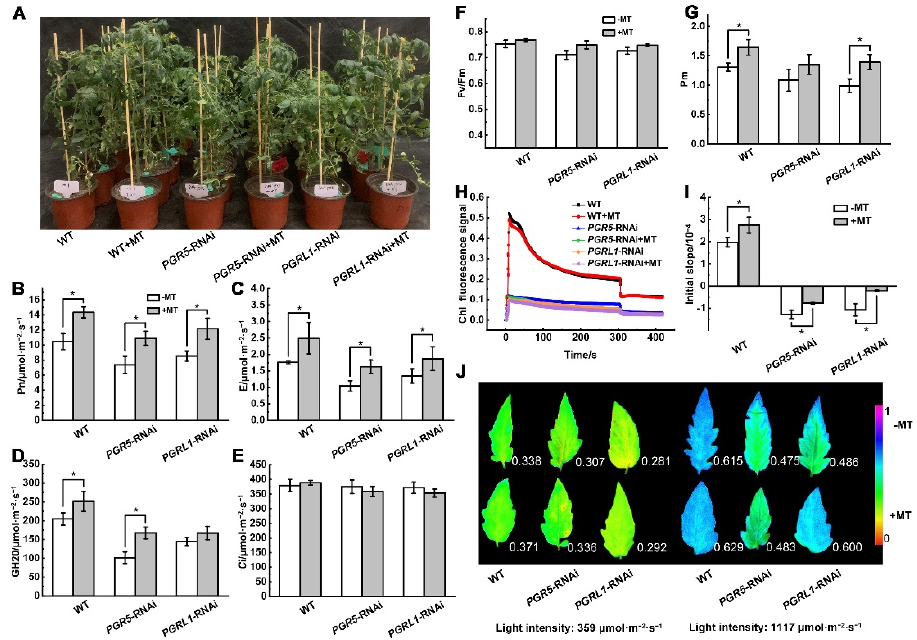
Figure 4. The effect of exogenous melatonin on photosynthetic gas exchange and chlorophyll fluorescence of tomato plants subjected to low night temperature. Plant phenotype ( A ); net pho- tosynthetic rate ( B ); transpiration rate ( C ); stomatal conductance ( D ); intercellular carbon dioxide concentration ( E ); maximum photochemical reaction efficiency of PSII ( F ); PSI maximum oxidation signal ( G ); chlorophyll fluorescence signal curve after turning the light off ( H ); the initial slope of the instantaneous increase of the signal after turning the light off ( I ); chlorophyll fluorescence imaging analysis of Y(NPQ) ( J ). Data are presented as the mean ± standard deviation of four to six independent biological replicates. * p -value < 0.05; student’s t